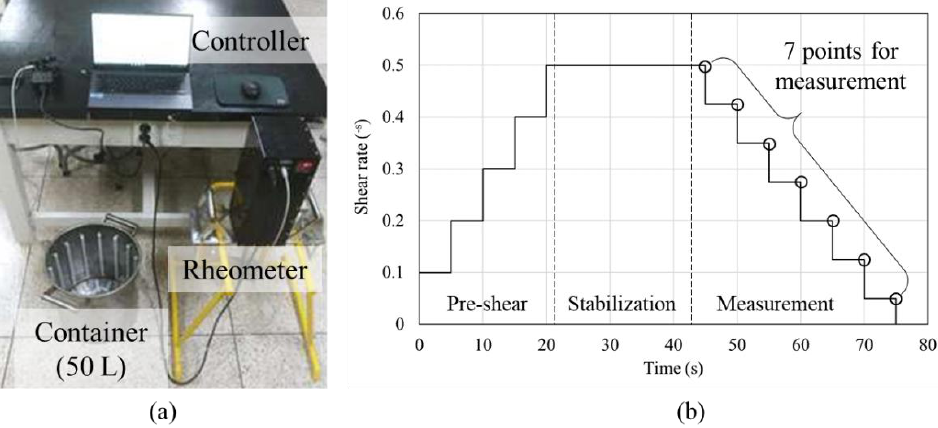
Figure 3. Rheometer and shear rate control program: ( a ) Rheometer; ( b ) share rate control